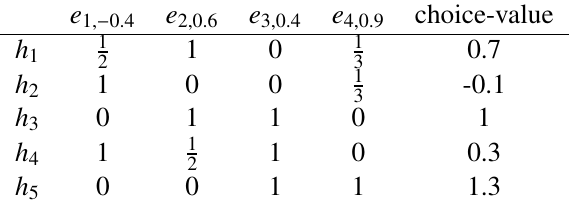
Table 3. The extended tabular representation of ( F , A ) with weights and choice